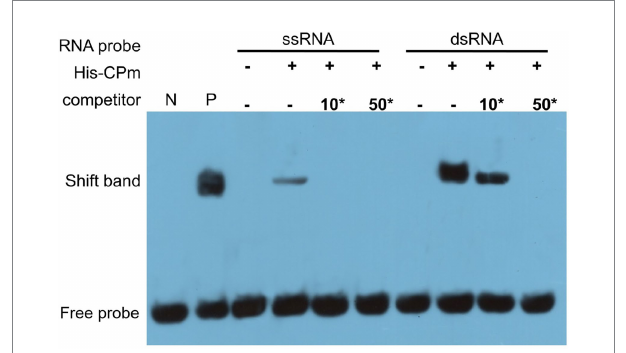
FIGURE 7 Tomato chlorosis viru s CPm binding the dsRNA, but not the ssRNA of GFP by electrophoretic mobility shift assay (EMSA). 10*, 10-fold dilution of probe; 50*, 50-fold dilution of probe. N, labeled dsRNA GFP probe was set as negative control; P, CAP protein of Escherichia coli co-incubated with the 5 ′ -biotinylated double-stranded GFP RNA probe was set as positive